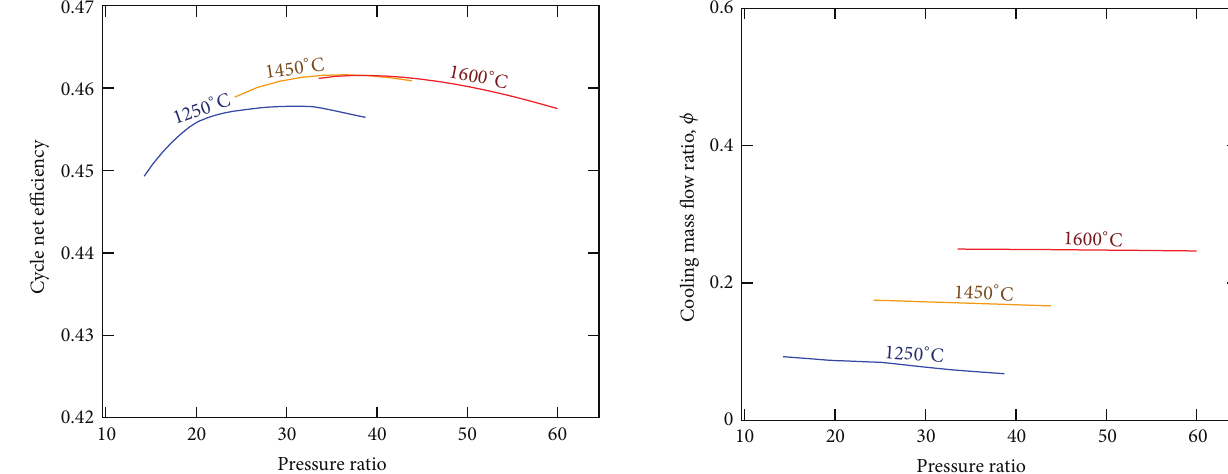
Figure 11: Net efficiency as function of pressure ratio and turbine entry temperature for the Graz cycle.